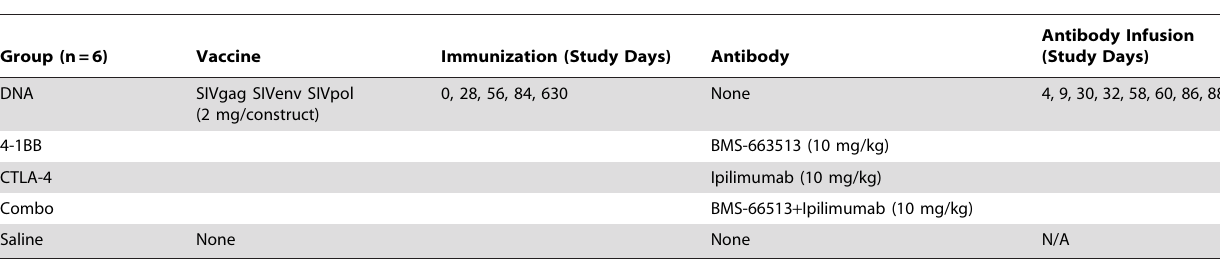
Table 1. Study design and immunization